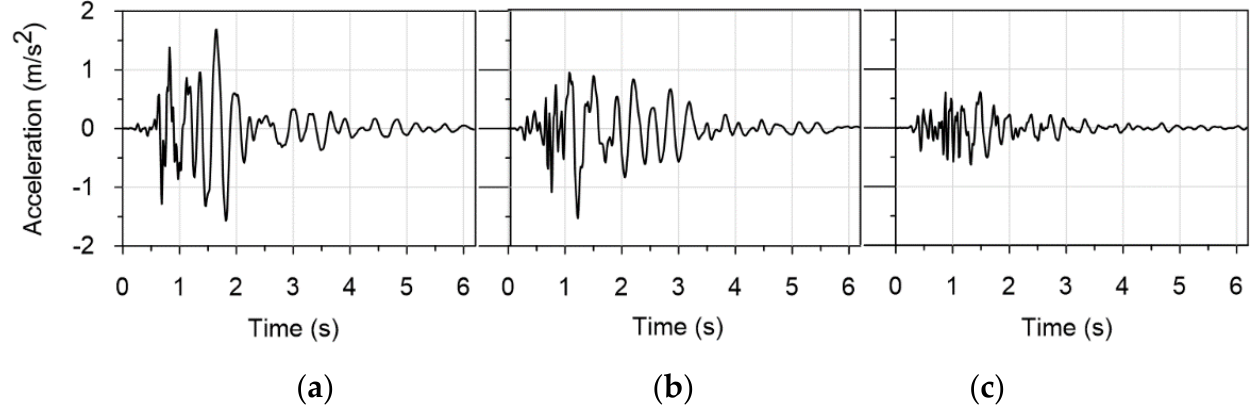
Figure 1. Acceleration-time histories of the shock recorded in the Upper Silesian Basin (USB) region: ( a ) horizontal direction W – E; ( b ) horizontal direction N – S; ( c ) vertical direction Z.